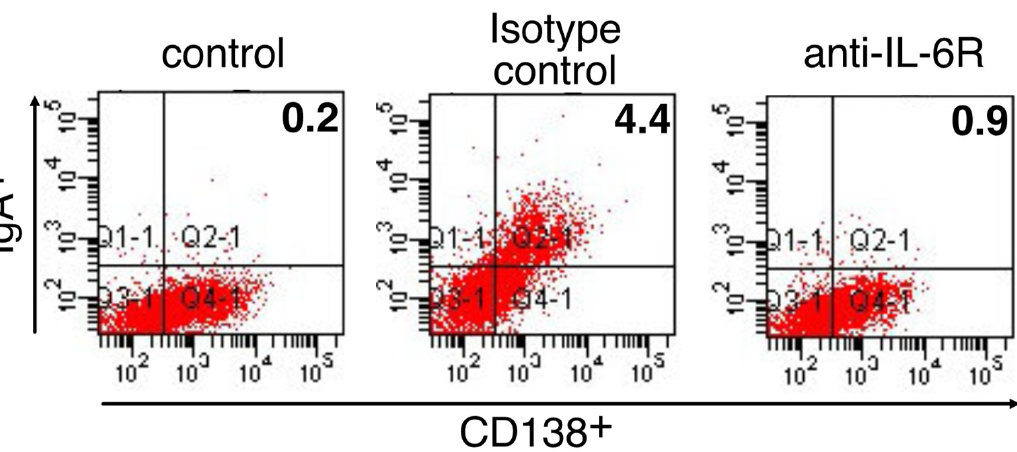
Figure 3. Influence of anti-IL-6R blocking antibodies on the differentiation into IgA + plasma cells in the nasal passage induced by CpG ODN-loaded cationic liposomes. BALB/c mice were intraperito- neally treated with anti-IL-6R antibody (250 μ g/mouse) or the respective isotype control antibody (250 μ g/mouse) two days prior to the first immunization (day -2) and 1 h prior to each subsequent immunization (days 0 and 7). Mice were then immunized intranasally with PBS or OVA (5 μ g/mouse) in combination with CpG ODN-loaded cationic liposomes (10 μ g/mouse as CpG ODN) at a volume of 13 μ L twice weekly. A week after the last immunization, IgA + plasma cells in the nasal passage were analyzed by flow cytometry. Control, n = 4; isotype control, n = 4; anti-IL-6R mAb, n = 4.